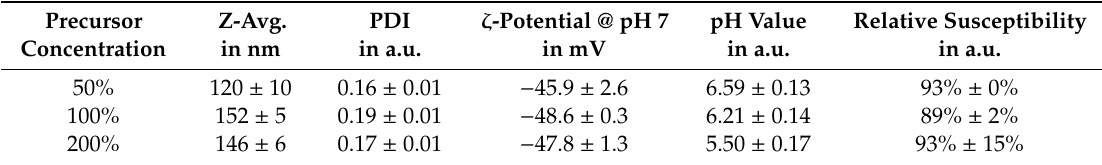
Table A2. Comparison of the parameters of Cit-Au-SPIONs with varied precursor concentrations. ζ -Potential @ pH 7 Precursor Z-Avg. PDI Concentration in nm in a.u. in mV